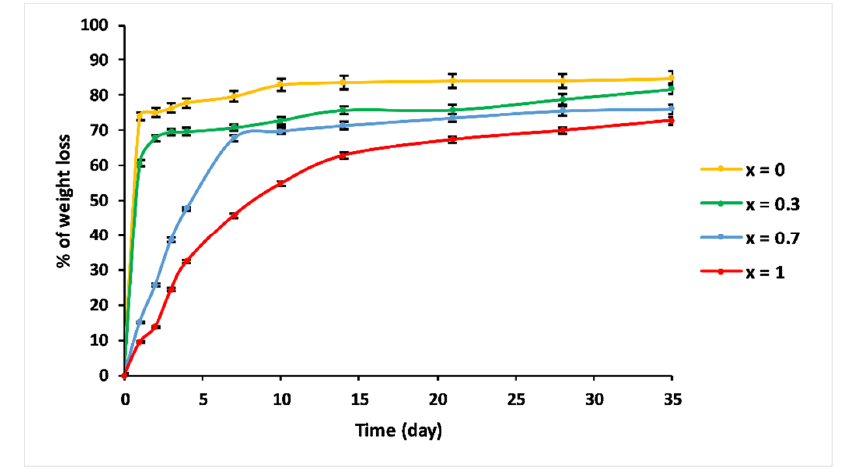
Figure 8. Trend of weight loss of 3P 2 O 5 -2K 2 O-(1 − x)CaO-xMgO (0 ≤ x ≤ 1) glasses versus immersion time at T = 25 °C. Table 3. Initial dissolution rates of 3P 2 O 5 -2K 2 O-(1 − x)CaO-xMgO (0 ≤ x ≤ 1) glasses at T = 25 °C.